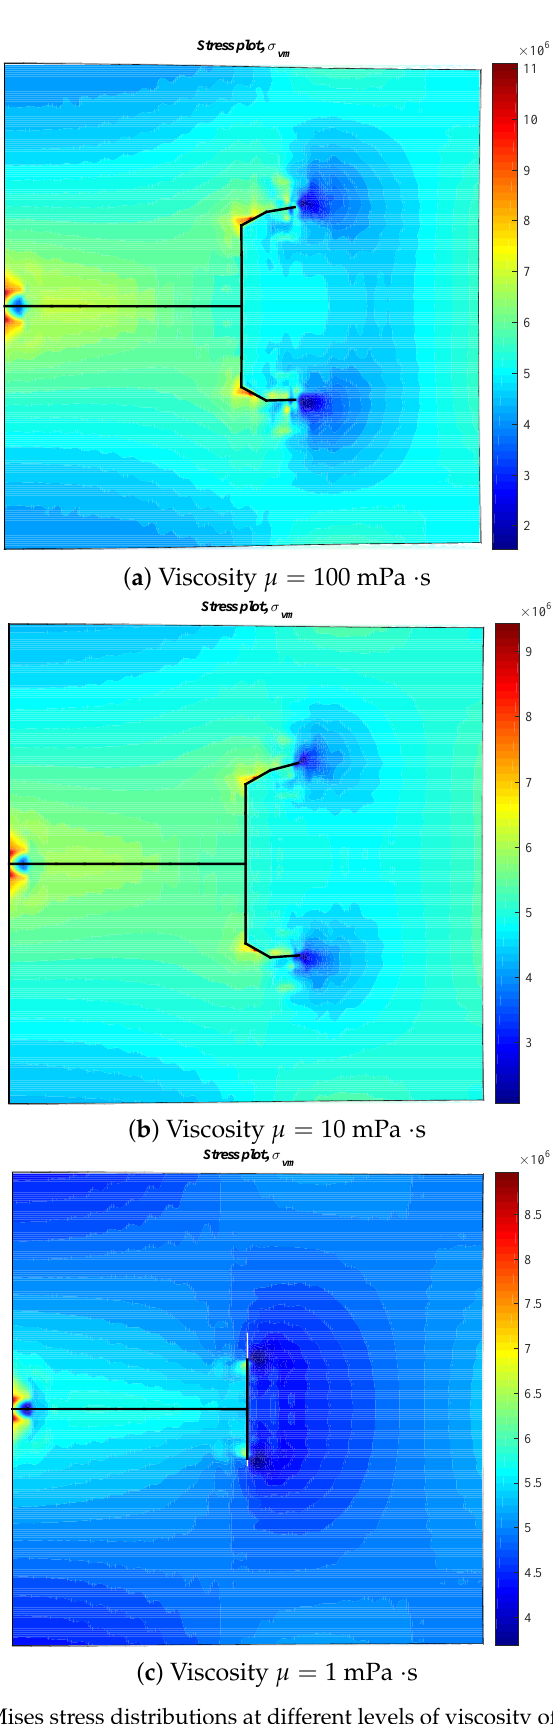
Figure 21. Von-Mises stress distributions at different levels of viscosity of fracturing